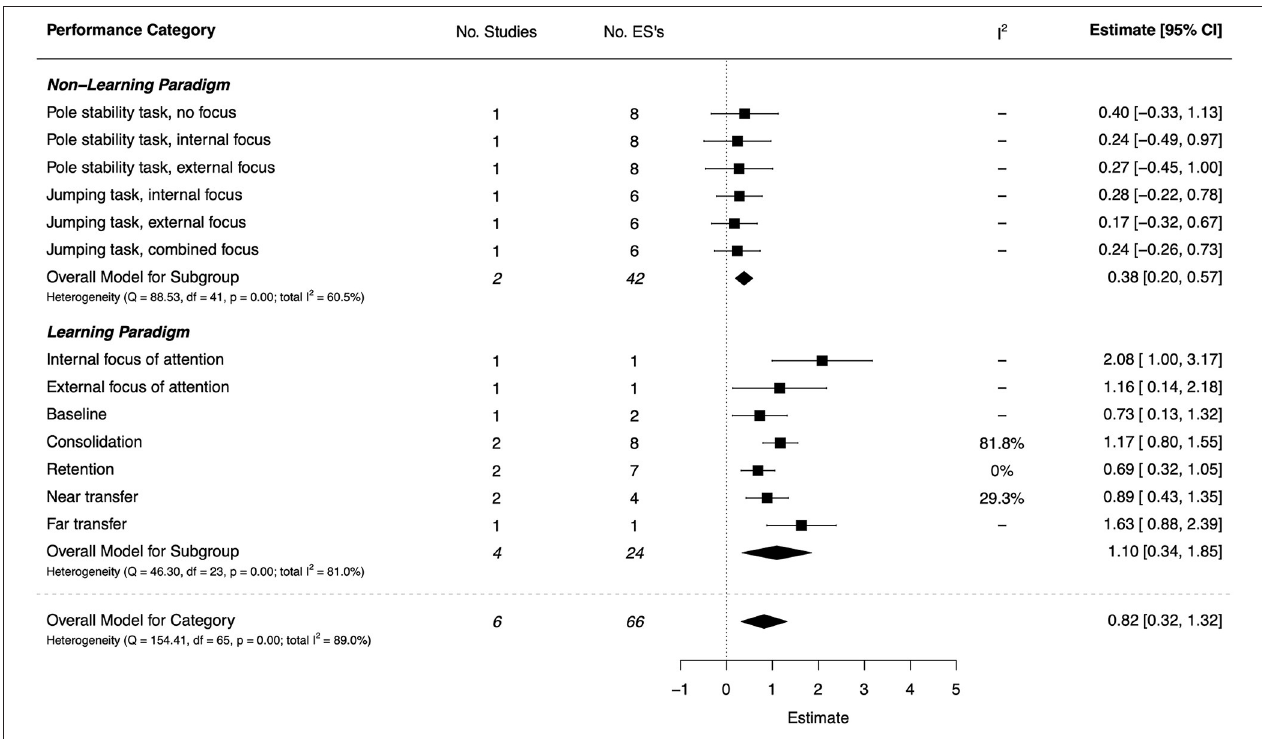
FIGURE 14 | Forest plot showing the meta-analysis results for the attentional focus and motor learning performance